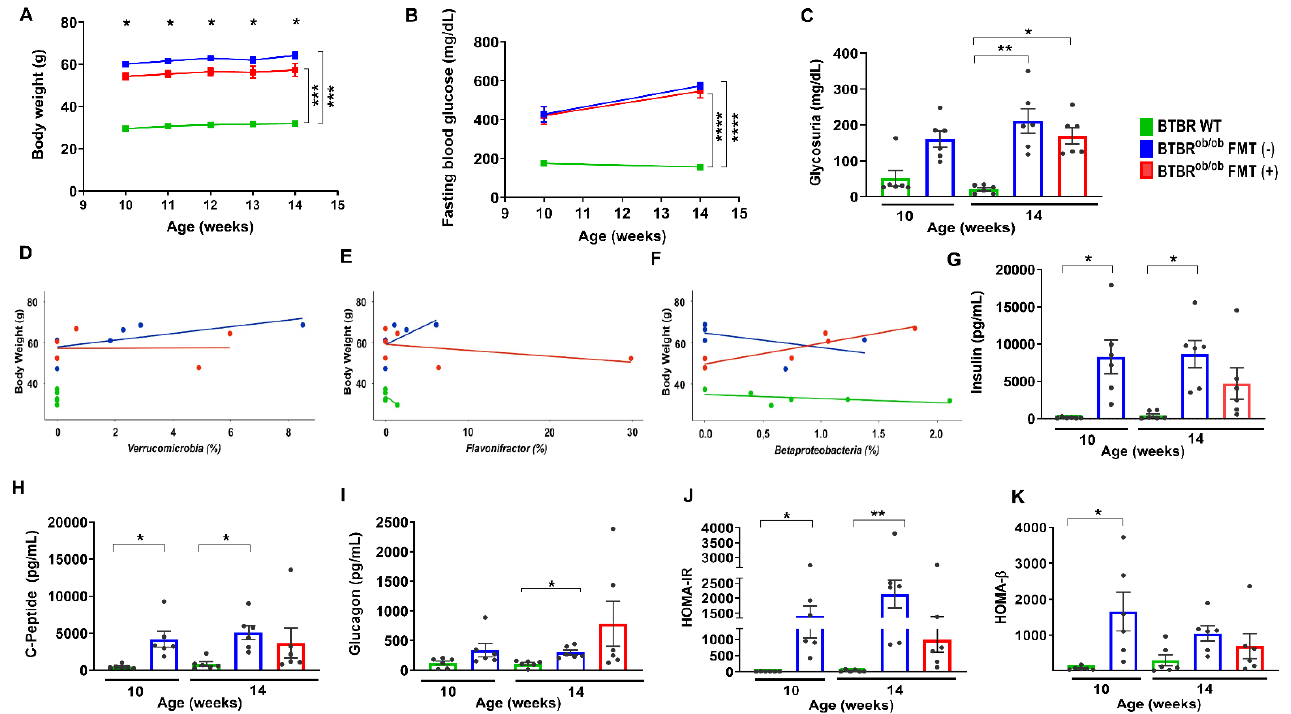
Figure 2. Analysis of the functional and metabolic parameters in BTBR ob/ob FMT (+) and BTBR ob/ob FMT ( − ) mice compared to BTBR WT mice. ( A ) BTBR ob/ob mice showed significantly higher body weight when compared to BTBR WT mice (*** p = 0.0001); however, 14-week-old BTBR ob/ob FMT (+) mice at all intervals gained less body weight than BTBR ob/ob FMT ( − ) mice (Row 1: * p = 0.03, Row 2: * p = 0.02, Row 3: * p = 0.02, Row 4: * p = 0.04, Row 5: * p = 0.01). ( B ) Fasting